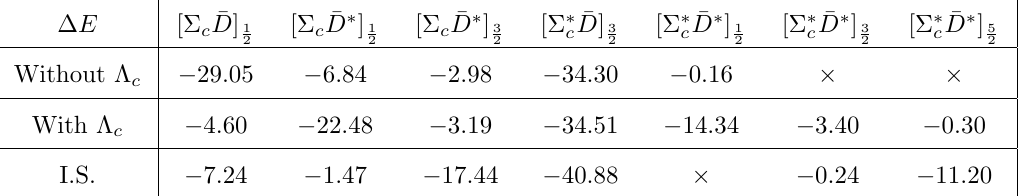
Table 2 . The binding energies (cid:1) E for the I = 1 with and without the (cid:3) c , as well as the case with J P = 1 values of ( D 1 ; D 2 ) for the \Without (cid:3) c " and \With (cid:3) c " cases are chosen to be (42 ; (cid:0) 12 : 5) GeV (cid:0) 2 and (52 ; (cid:0) 4) GeV (cid:0) 2 , respectively. \I.S." stands for the results when interchanging the spins of P c (4440) and P c (4457), where ( D 1 ; D 2 ) = (58 ; (cid:0) 31) GeV (cid:0) 2 in this case. \ (cid:2) " means no binding solution (in units of